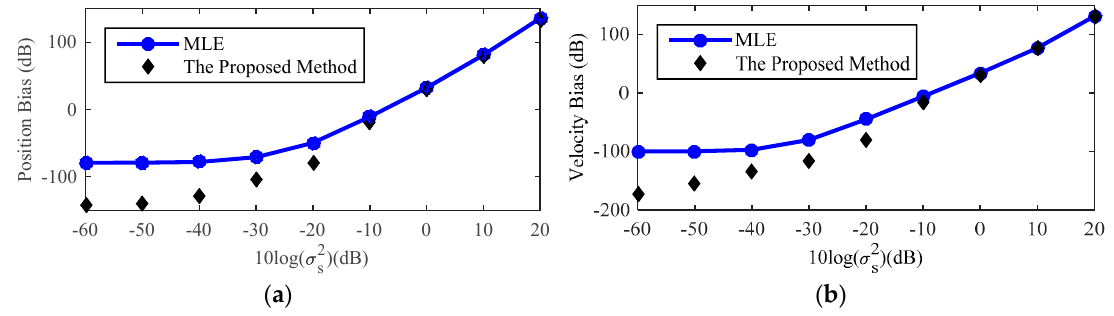
Figure 9. Bias comparison of the proposed method with the original MLE for near-field source. ( a ) Position Bias; ( b ) Velocity Bias.